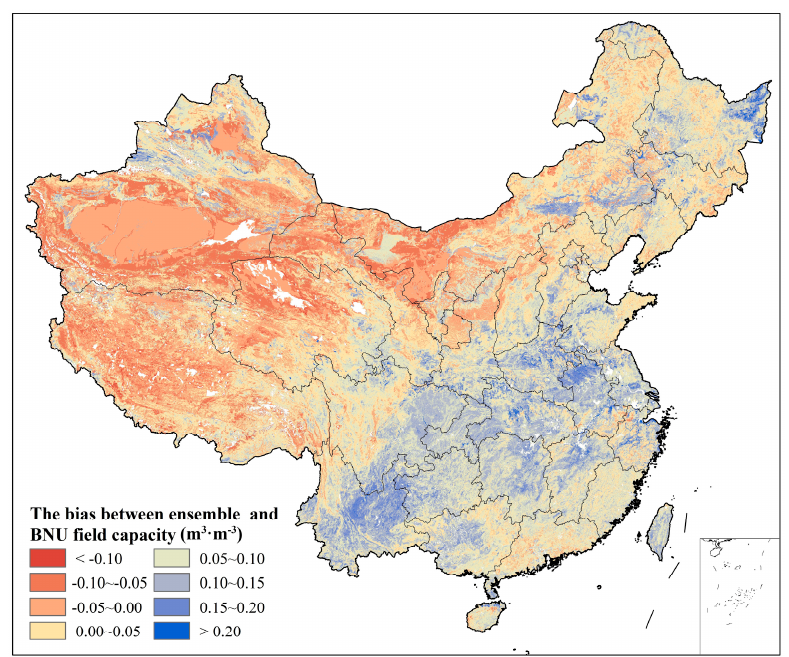
Figure 10. Bias between ensemble field capacity and BNU field capacity. Bias was calculated by subtracting the BNU field capacity from ensemble field capacity.